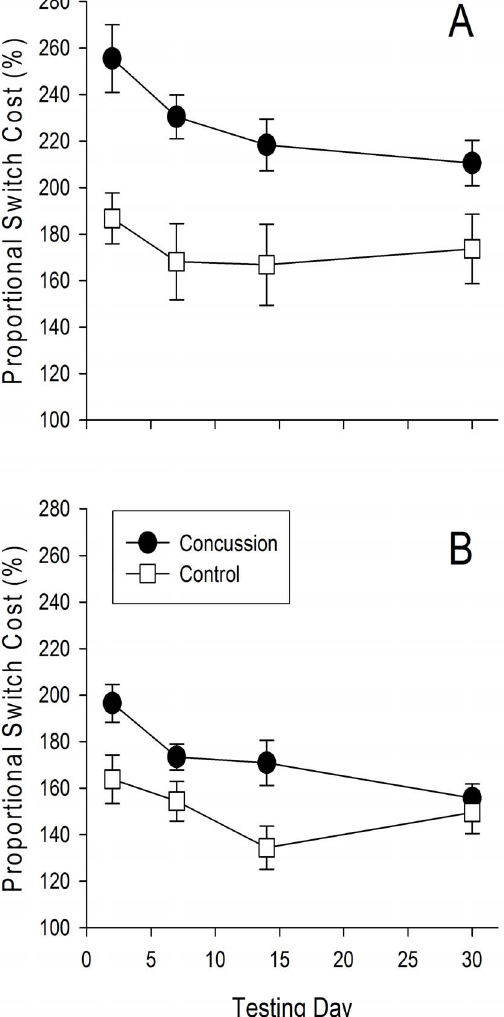
Figure 2. Switch Cost. Switch cost across the 4 testing days in the spatial (A) and numerical (B) versions of the switch task for the participants with concussion ( black circles ) and controls ( white squares ). Error bars, 1 intersubject SE .